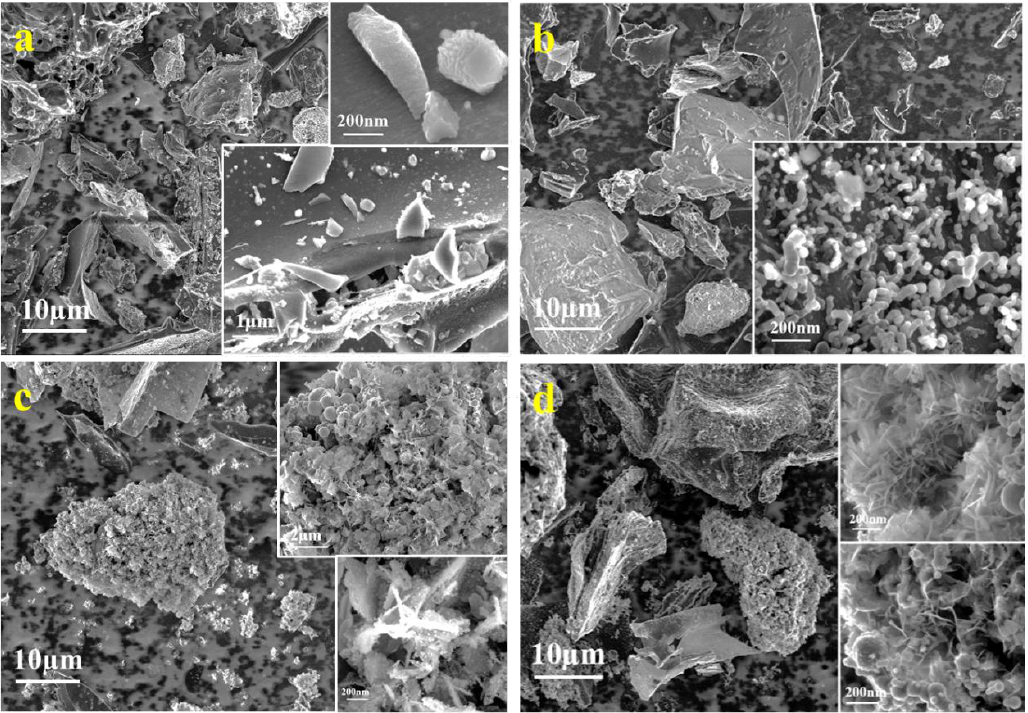
Figure 2. SEM imagines of biochar materials ( a ) BC, ( b ) B6@BC, ( c ) nZVI@BC, and ( d ) nZVI/B6@BC.